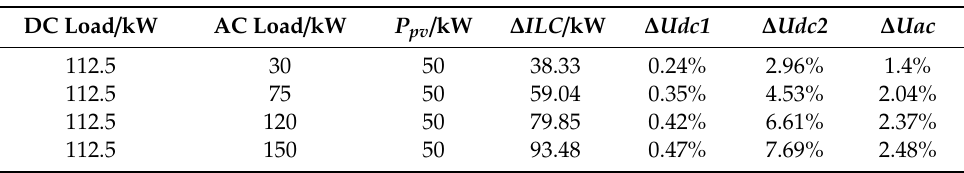
Table 3. AC / DC hybrid micro-grid operating